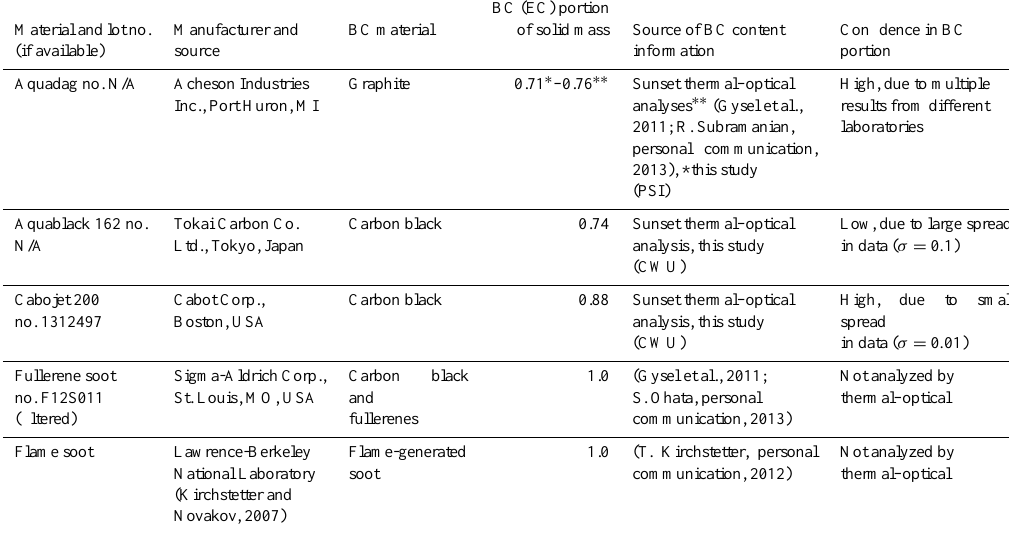
Table B1. Various BC materials mentioned in this manuscript.